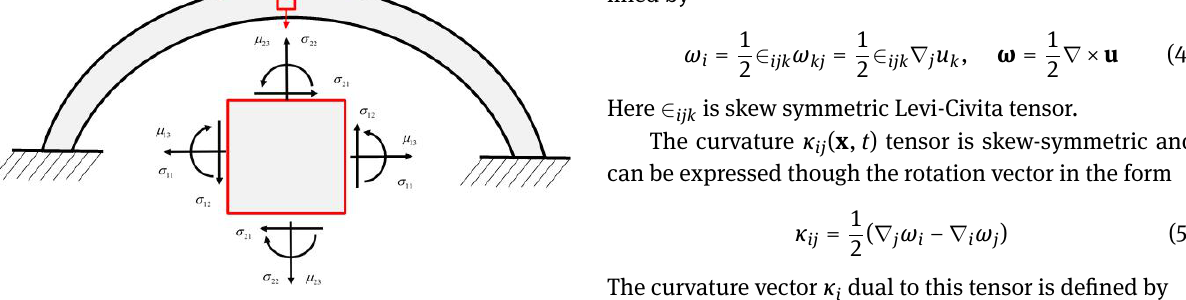
Figure 1: Curved elastic